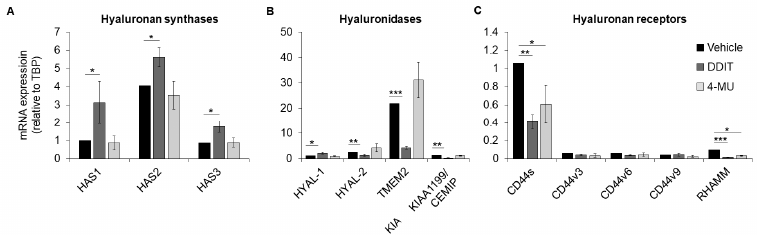
Figure 6. Effect of DDIT on the mRNA expression of hyaluronan synthases, hyaluronidases and hyaluronan receptors. The expression of mRNA for hyaluronan synthases ( HAS1 , HAS2 and HAS3 ) ( A ), hyaluronidases ( HYAL-1 , HYAL-2 , TMEM2 and KIAA1199/CEMIP ) ( B ) and hyaluronan receptors ( CD44s , CD44v3 , CD44v6 , CD44v9 and RHAMM ) ( C ) was determined by RT-qPCR in Hs578T breast cancer cells after treatment with vehicle (0.04% DMSO), DDIT (80 μ M) or 4-MU (1